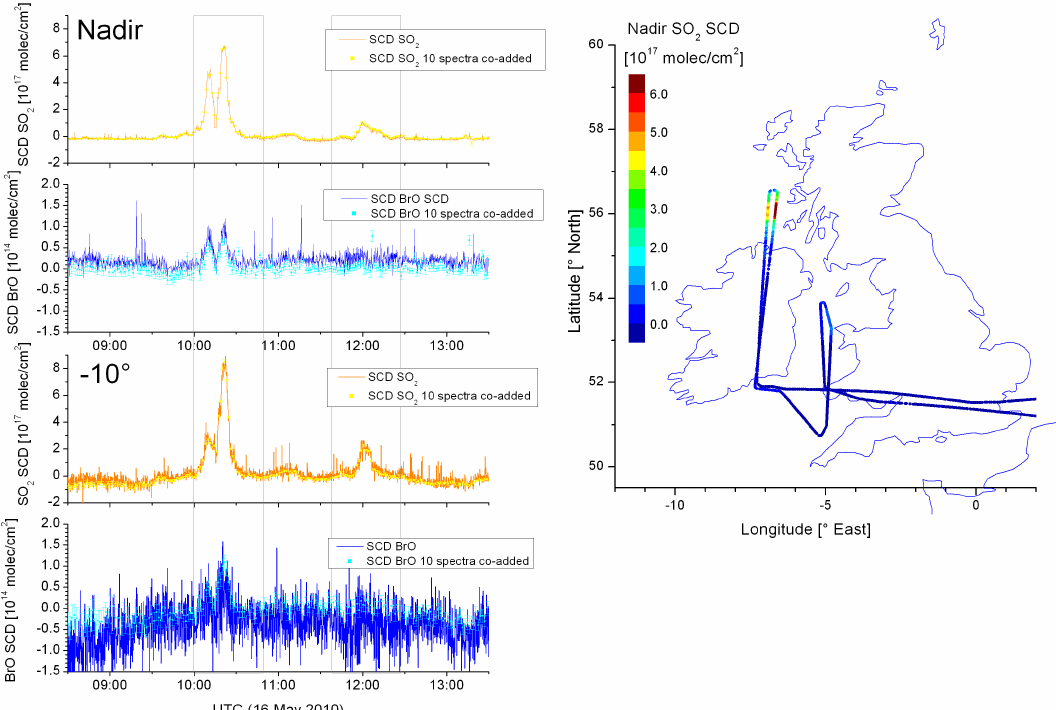
Fig. 5. Time series of the SO 2 and the BrO CARIBIC DOAS SCDs for nadir and -10 ◦ and the spatial SO 2 distribution (right) for nadir. The two strong enhancements can clearly be attributed to the same plume which was crossed twice just before and after the u-turn north of Ireland. The boxes indicate the two time intervals during which the collected aerosol samples showed clear evidence of volcanic ash (samples No 4 and No 6).